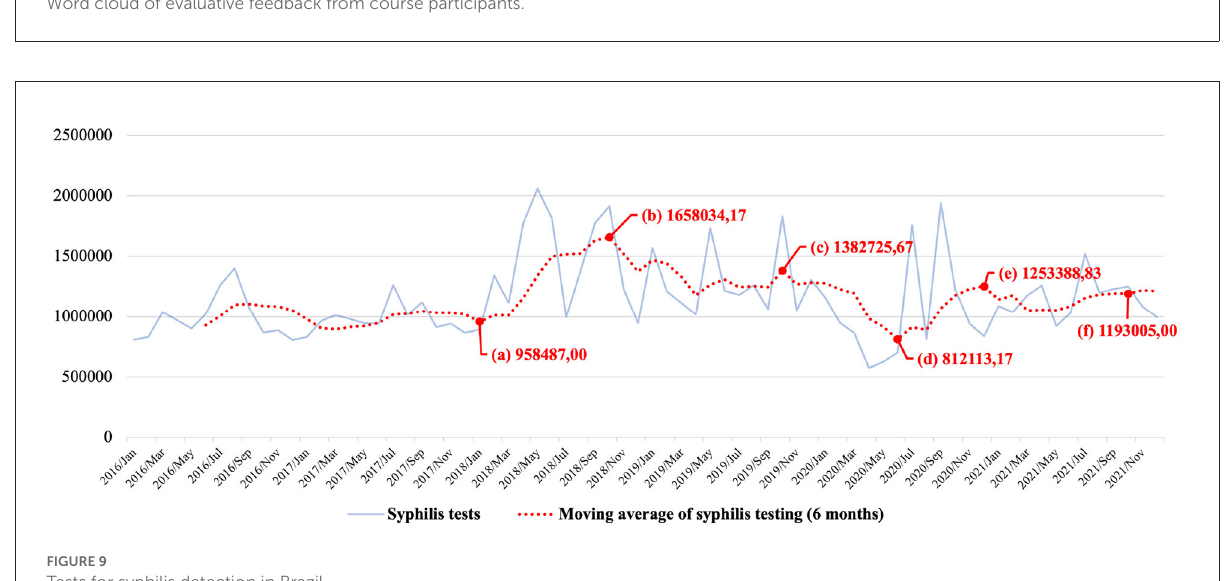
FIGURE9 Tests for syphilis detection in